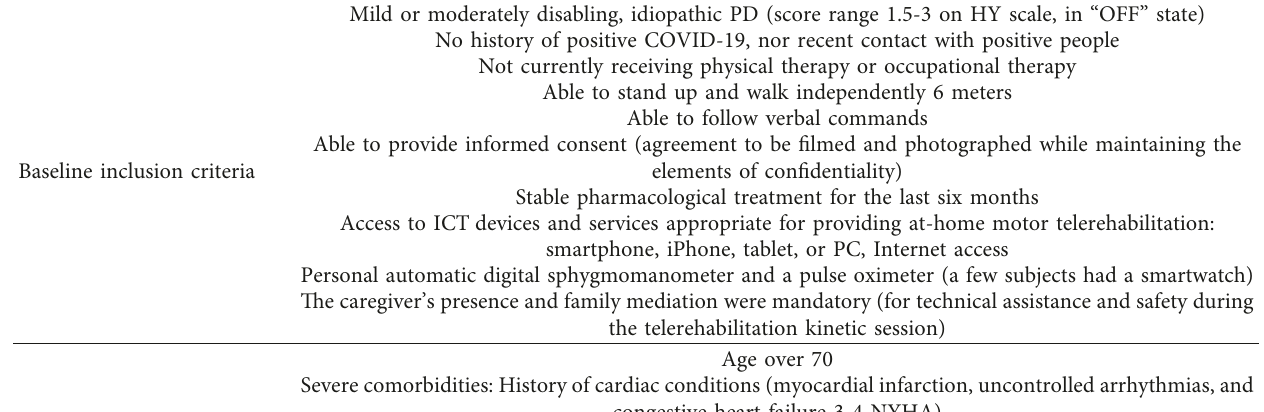
Table 1: Participant selection